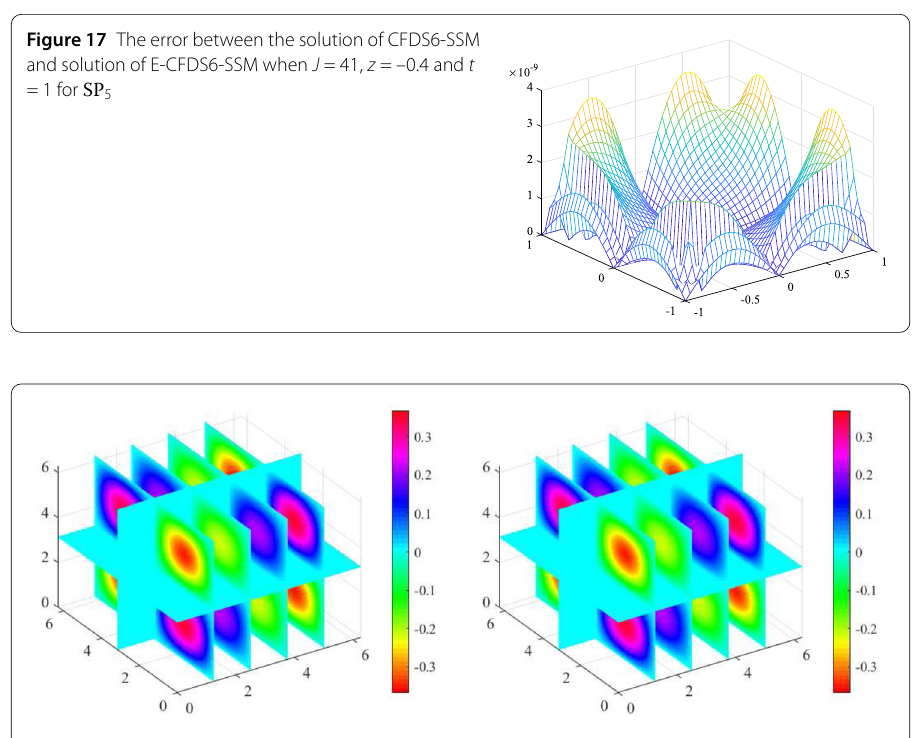
Figure 18 The numerical solution of CFDS6-SSM (left-hand side) and E-CFDS6-SSM (right-hand side) when J = 41 and t = 1 for SP 6